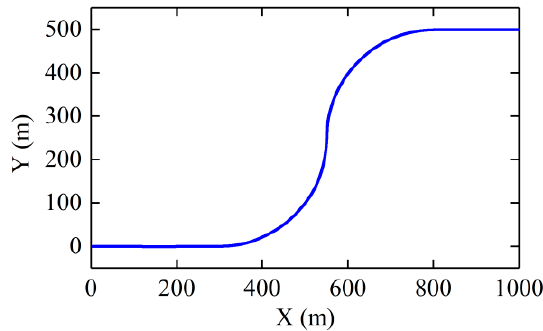
Figure 11. Curve path in the simulation model.